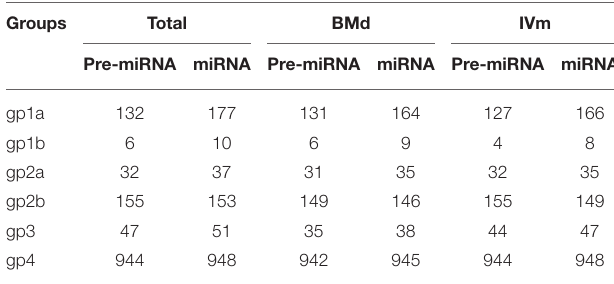
( Figure 2 ). The relative expression of miRNAs in Vm -infected apple twig compared with the mock-inoculated control was also analyzed with the reads’ abundance. The samples showed various expression profiles when apple twig was challenged with Vm ( Figure 3 ). Among them, 294 miRNAs were down-regulated when apple twigs were challenged with Vm , including 48